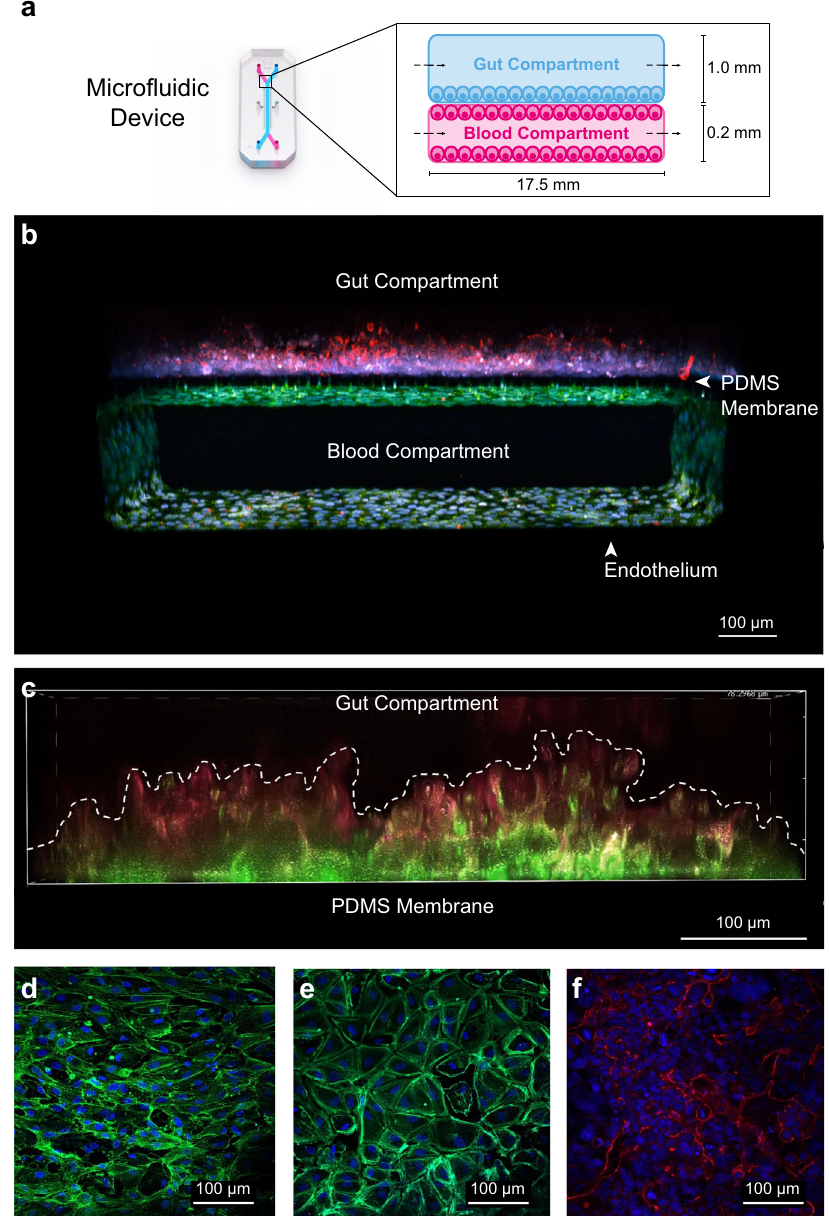
Fig. 1 Characterization of a micro fl uidic human gut-chip model. a Schematic representation of two-compartment gut-chip model design. Human enterocyte-like (Caco2-BBE) and goblet-like cells (HT-29 MTX) were co-cultured in the upper channel (gut compartment) and interfaced with microvascular endothelial cells in the lower channel (blood compartment), through a thin, porous, fl exible membrane. ( b , n = 3 gut-chips) Confocal z-stack micrograph of the human gut-chip model, displaying the fully vascularized endothelial channel (bottom, green — ZO-1) and its interface with the gut epithelial barrier (upper channel, red — ZO-1) post-10 days of maturation. ( c , n = 3 gut chips) Continuous dynamic culture (stretch 10% strain, 0.25 Hz and physiological fl ow = 60 µ L/h; 0.0003 dynes/cm 2 ) of the Caco2 intestinal cells leads to spontaneous 3D morphogenesis, producing villus-like projections (120 – 150 µ m, red — phalloidin Alexa- fl uor 555, green — ZO-1) within the gut compartment. ( d – f , n = 2 gut chips) Micrographs of the crucial gut-vascular interface displaying endothelial tight junctions ( d , e ; green — ZO-1, blue — DAPI) and gut epithelial tight junctions ( f ; red — ZO-1, blue —